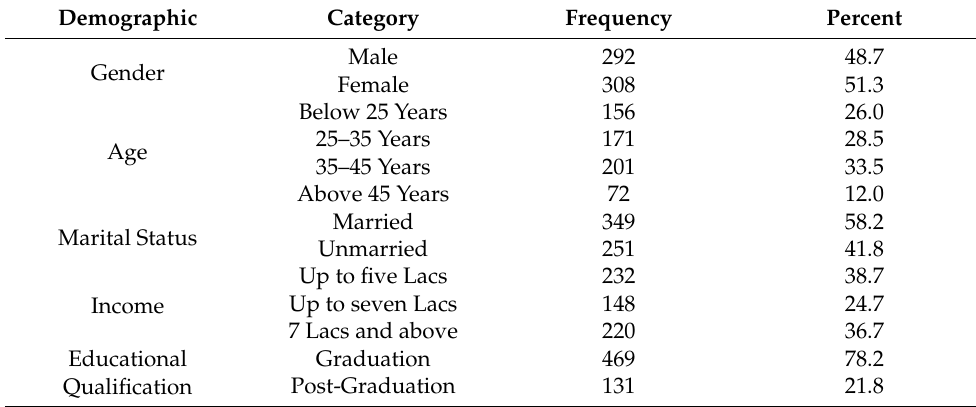
Table 1. Demographic Characteristics of the